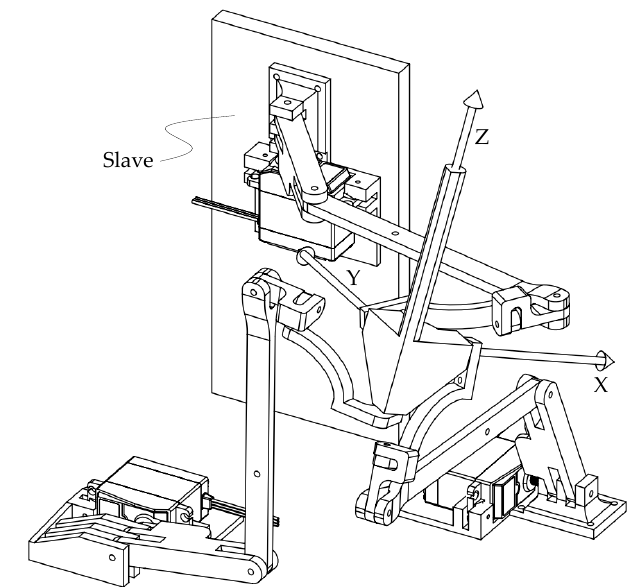
Figure 2. The slave